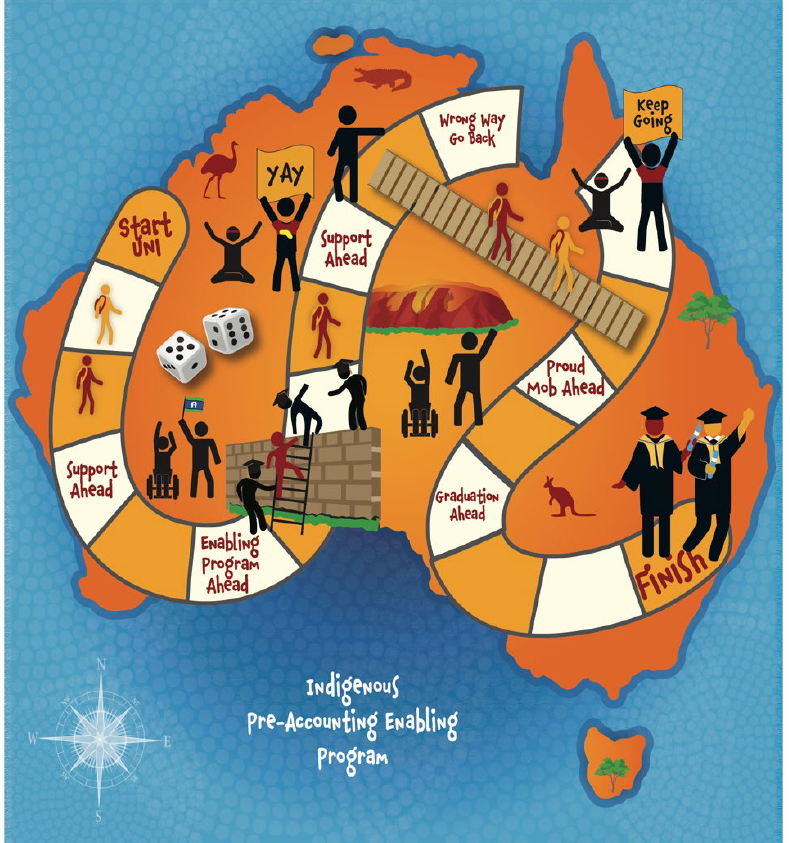
Figure 1: Collaborative design of Indigenous Pre-Accounting Enabling Program